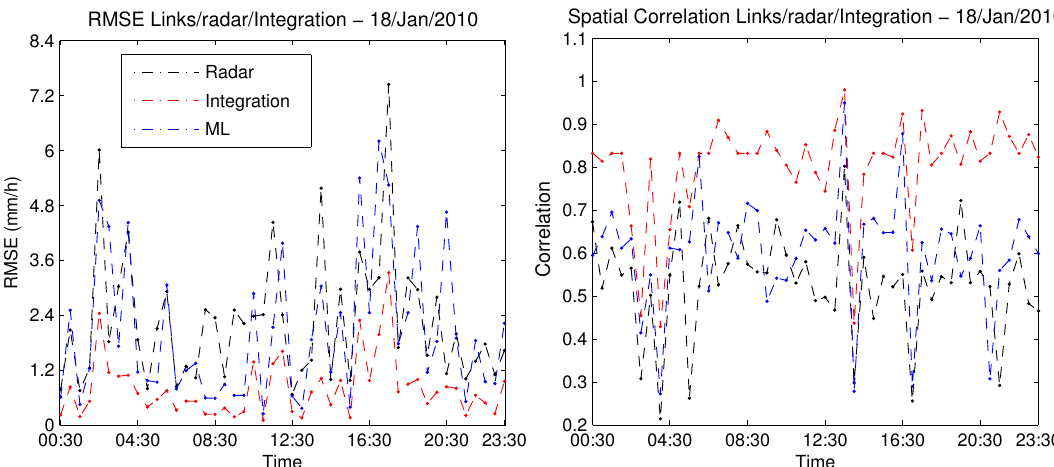
Figure 7. Evaluation analysis of event 1, where the radar (black line), the proposed integration technique (red line) and ML (blue line) are compared to the rain gauges at the common times. Left: RMSE. Right: spatial correlation.